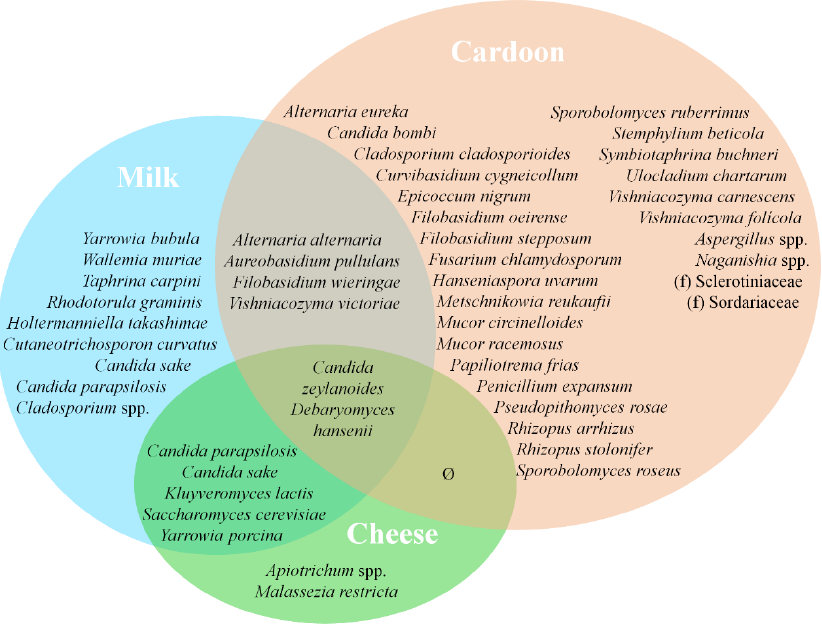
Figure 10. Venn diagram representing shared core taxa of fungi between raw ewes’ milk (blue area), cardoon (red area) and Serra da Estrela cheese (green area) matrices. f denotes identified bacterial families without taxonomic attribution to genus and/or species.